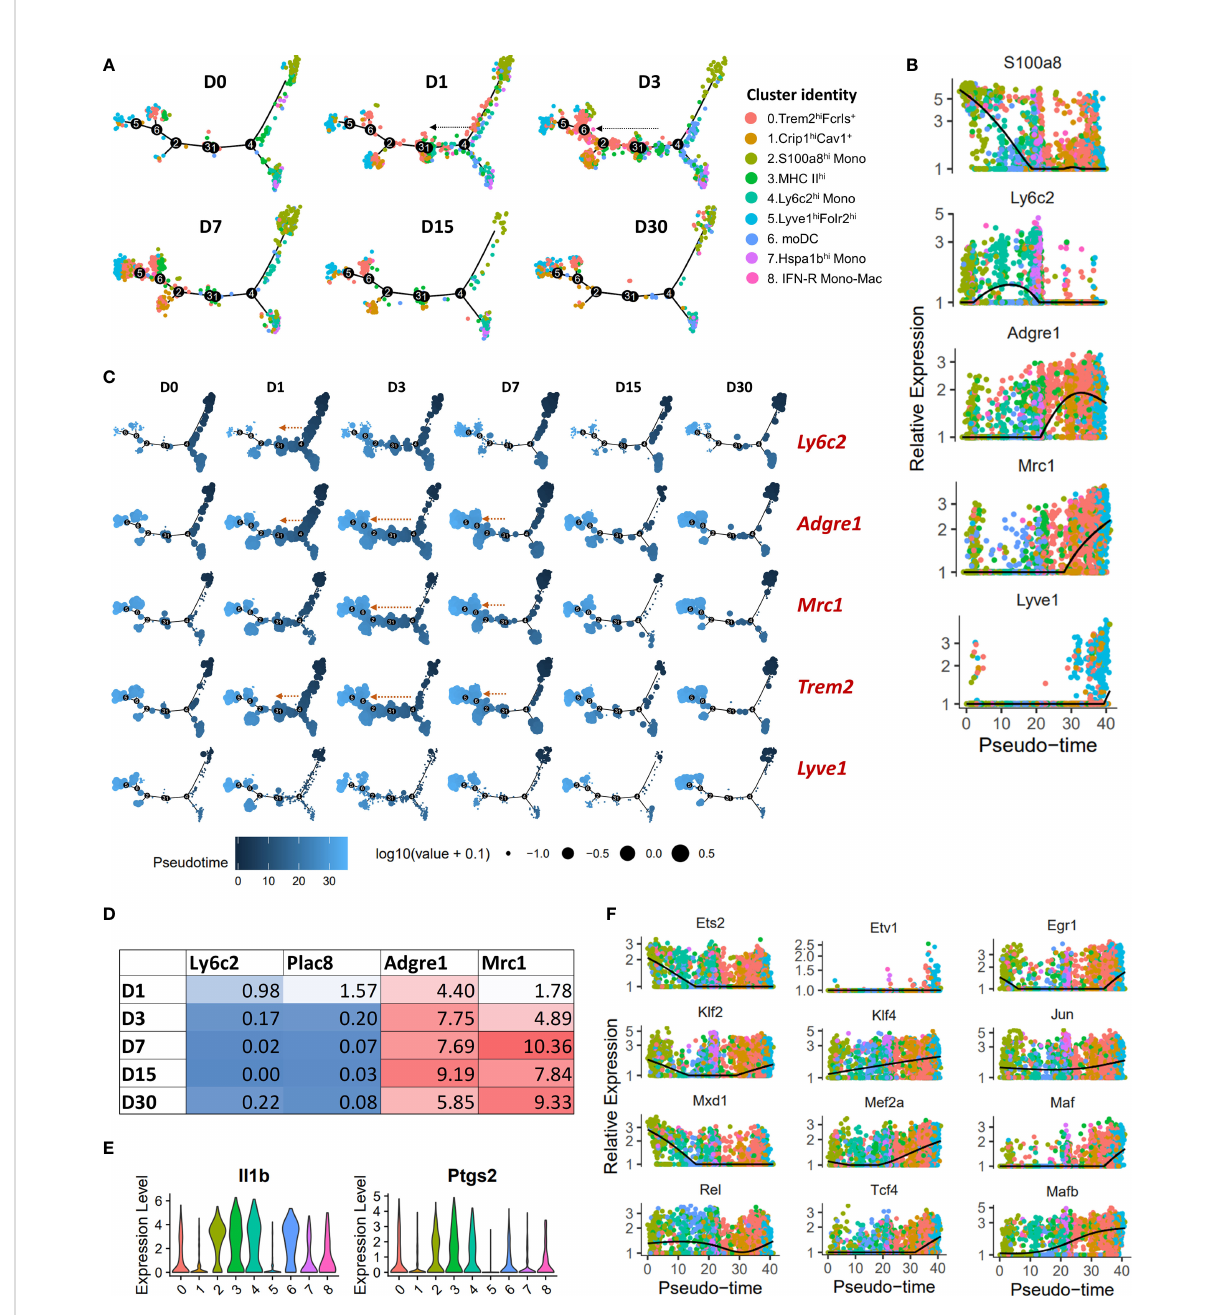
FIGURE 3 Pseudo-time differentiation trajectory analysis of monocytes and macrophages from D0-D30. (A) The relative position of cells across the pseudo-time differentiation trajectory is depicted. Each point is a cell and is colored according to its cluster identity. Cells along the trajectory were divided into six groupings based on experimental timepoints (D0-D30). An expansion of Trem2 hi Fcrls + population in monocytes ! macrophage direction was observed after injury, primarily at D1 and D3 (indicated by arrows). (B) Expression of monocyte and macrophage markers on a pseudo-time scale (each point represents a cell and is colored based on cluster identities in panel (A) ). Monocyte markers were highly expressed at the beginning of the differentiation trajectory while Mrc1 and Lyve1 had the highest expression towards the end. (C) Superimposition of the expression of selected genes on the pseudo-time trajectory. Each point is a cell and is colored according to its pseudo- time value. Circle size represents the gene expression level. Expansion of cell populations expressing high levels of Adgre1, Trem2 and Mrc1 in the monocyte ! macrophage direction was observed after injury (indicated by arrows). (D) Average expression of monocyte and macrophage markers in Trem2 hi Fcrls hi cluster. (E) Violin plots showing elevated Il1b and Ptgs2 expression in MHC II hi macrophages (cluster 3). MHC II hi macrophages and monocytes/moDCs expressed higher levels of Il1b and Ptgs2 compared to other macrophage clusters, including Trem2 hi Fcrls + and Lyve1 + macrophages. (F) Plots showing pseudo-time-ordered expression of selected transcription factors (cells are colored based on cluster identities in panel (A)